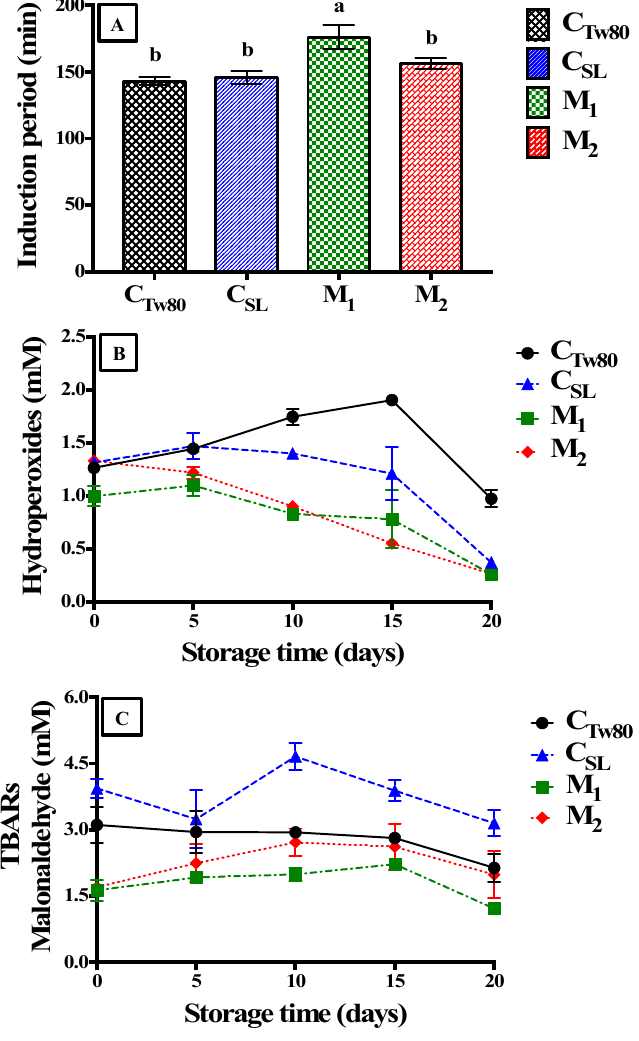
Figure 3. Oxidative stability of nanoemulsions elaborated with different emulsifiers mixtures and control samples: induction period ( A ), primary oxidation ( B ) and secondary oxidation ( C ). M 1 :